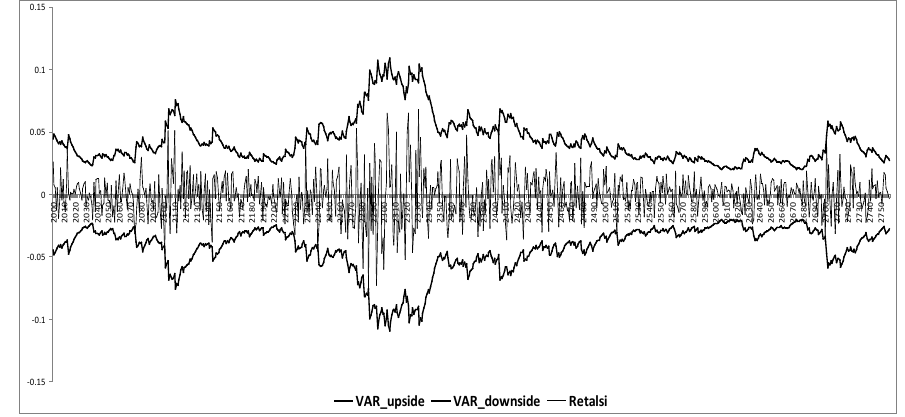
FIGURE 5: Garch-GPD Source: Authors’ calculations, based on JSE ALSI return series